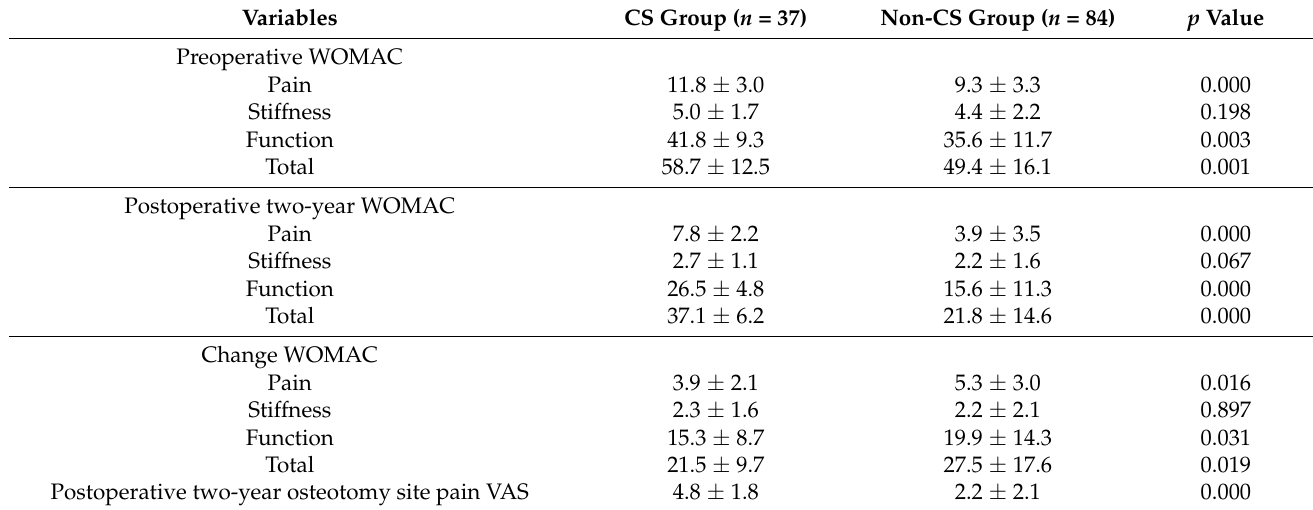
Table 2. Preoperative and two-year postoperative WOMAC scores and two-year postoperative osteotomy site